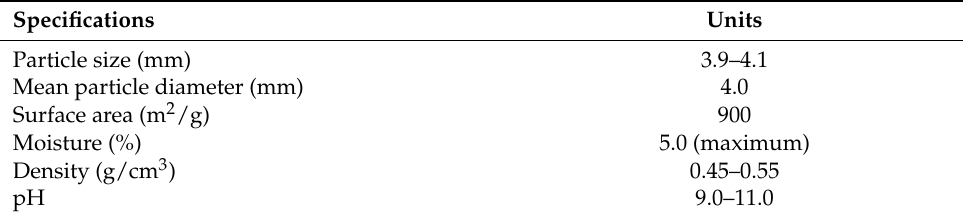
Table 1. Specifications of commercial grade carbon pellets for activation.